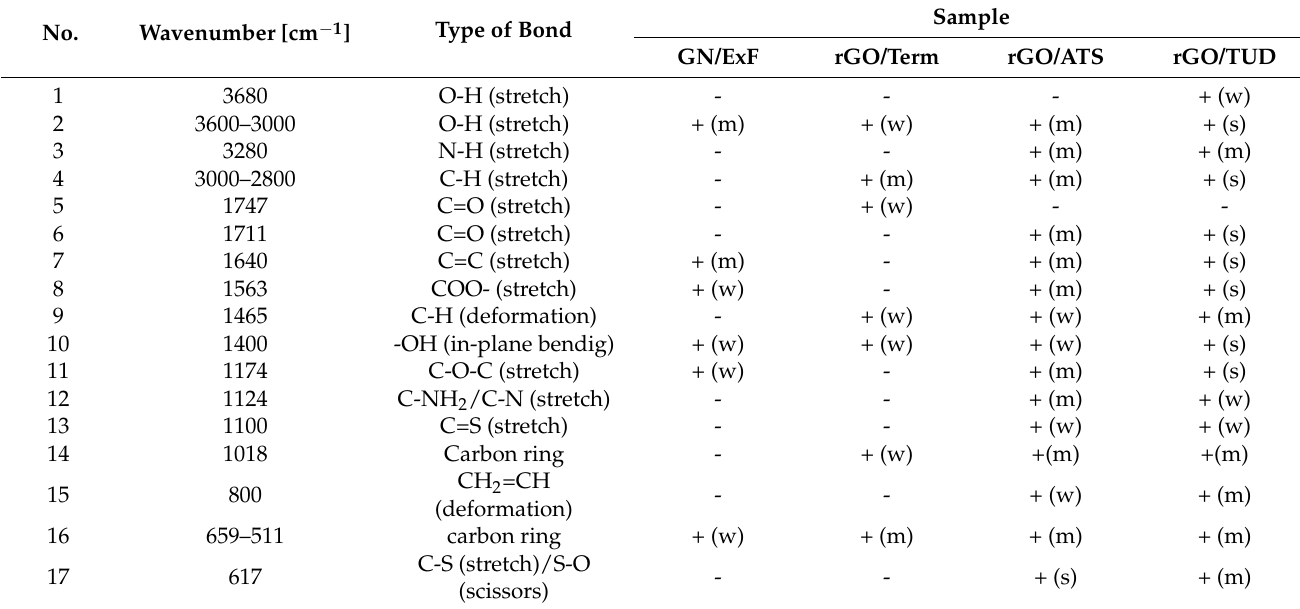
Table 1. Location of absorption bands exhibited by the functional groups in FTIR spectra obtained for individual GN and rGO